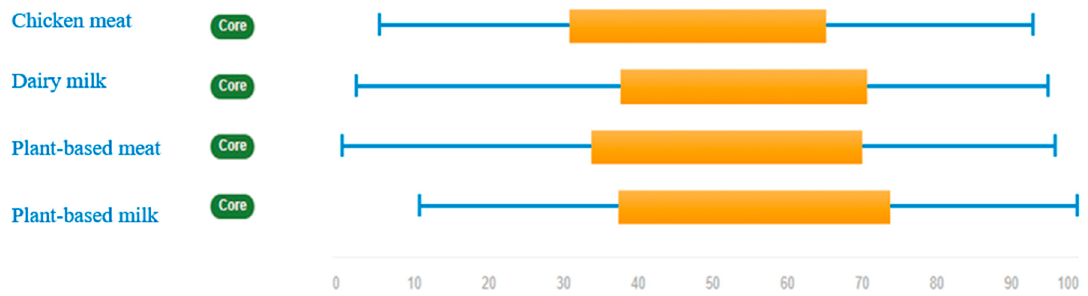
Figure 2. Overall ranking of food products (all stakeholder’ views). Solid orange bars show rank means (the left and right ends indicate the means of the low and high ranks assigned by each stakeholder). Thin blue lines refer to rank extrema (the left and right ends indicate the lowest and highest ranks assigned by any stakeholder).